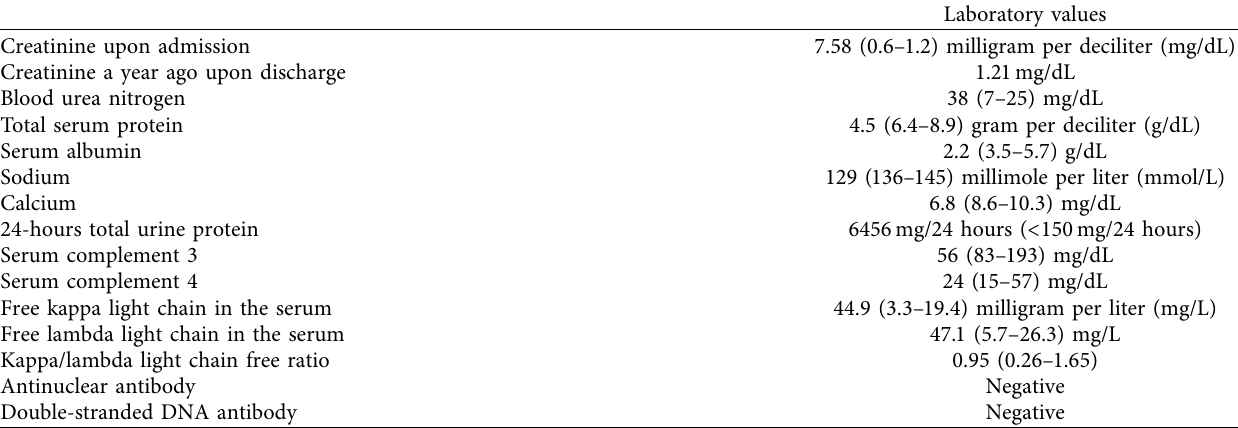
Table 1: Laboratory values on admission and a year ago.